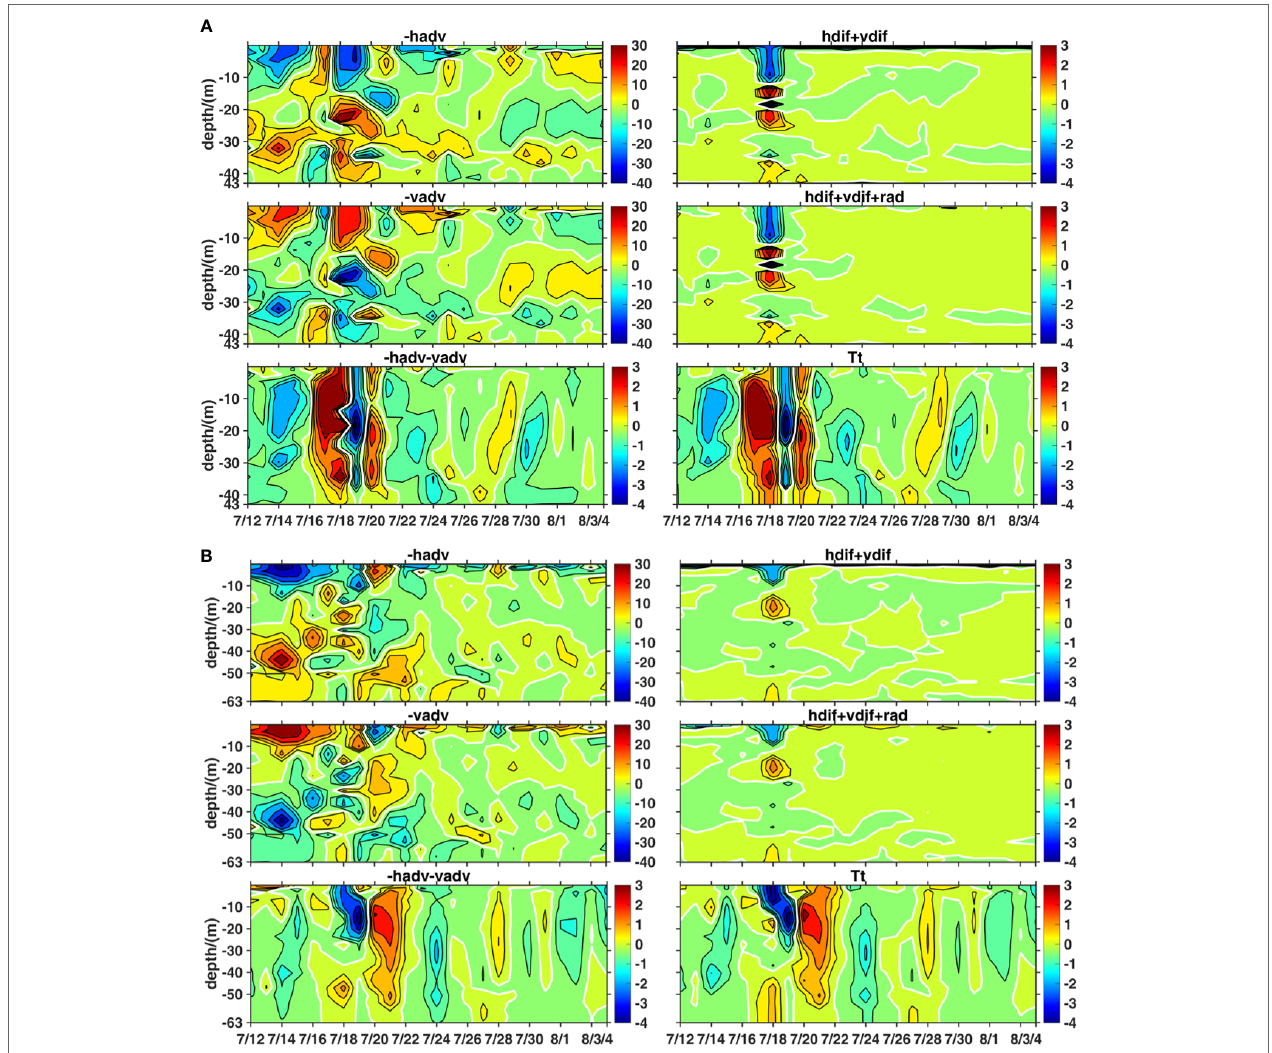
FIGURE 13 | Temperature transport term decomposition at stations B (A) and A (B) from July 12 to August 4. The unit of each term is